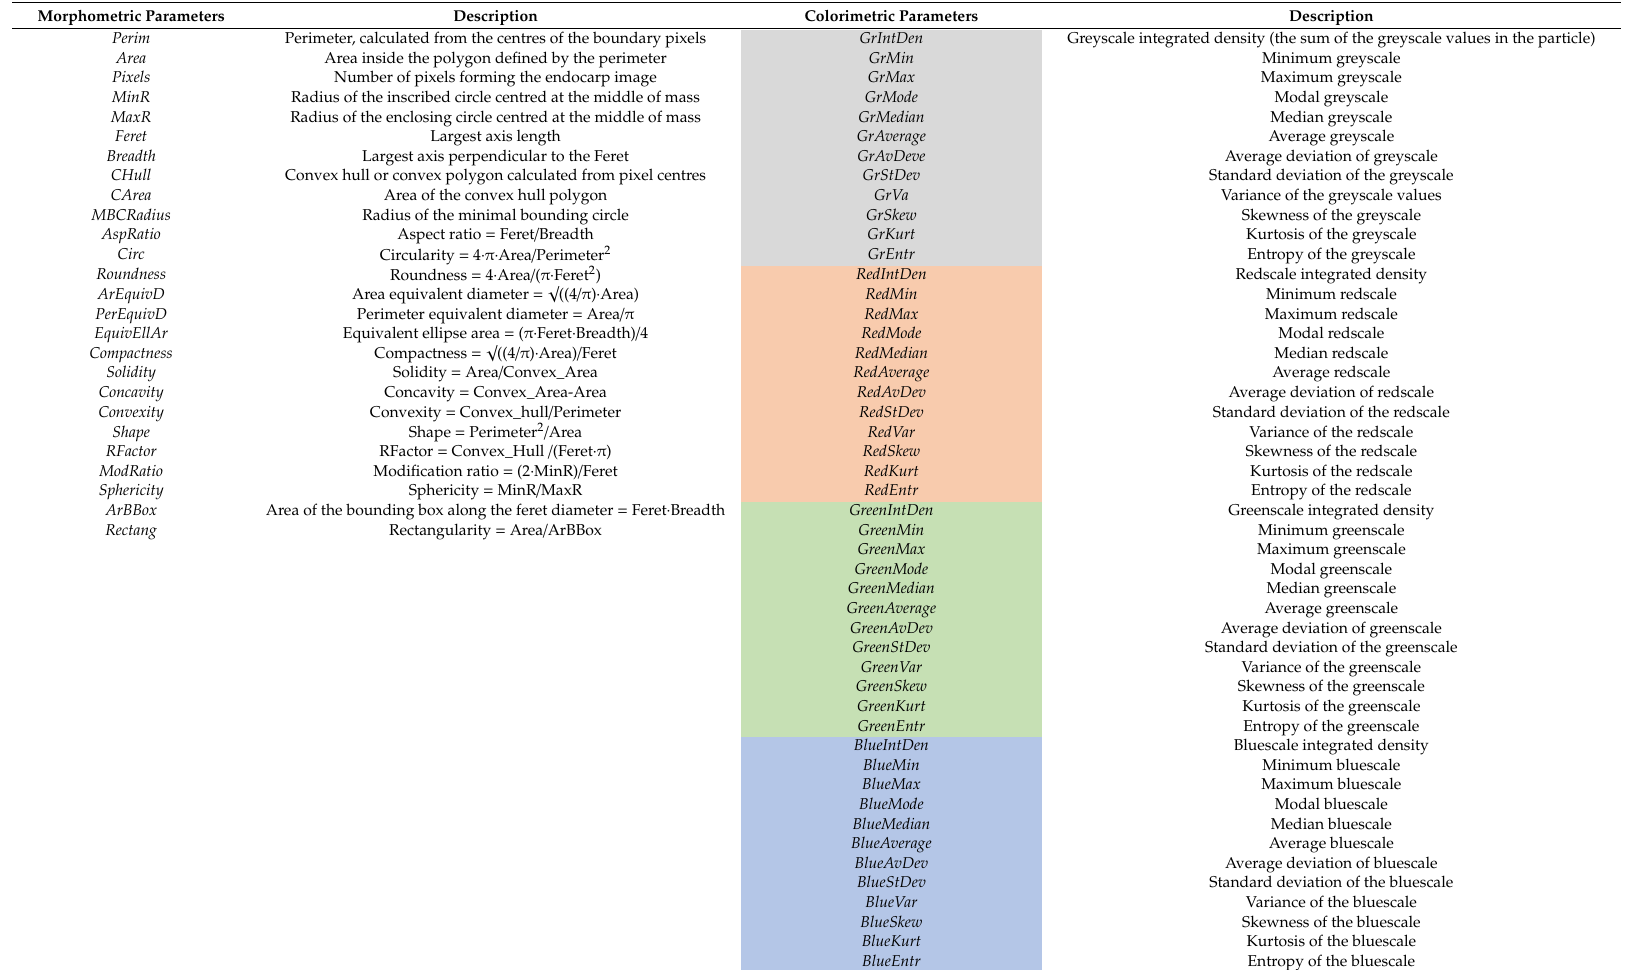
Table 3. List of the 74 morpho-colorimetric parameters measured on each seed variant and calculated by Particles8 plugins from ImageJ v. 1.49. Morphometric